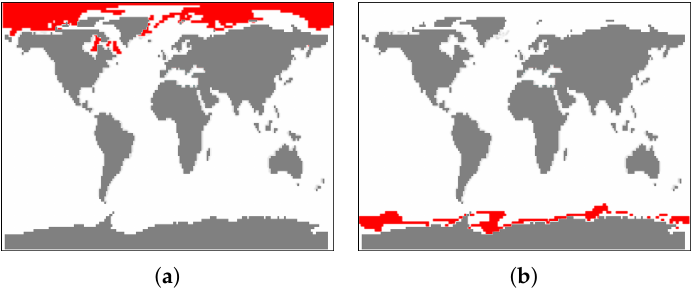
Figure 17. Coordinated views to physical space visualizations of selections in Figure 16 exhibit that selections correspond to arctic region ( a ) and antarctic region ( b